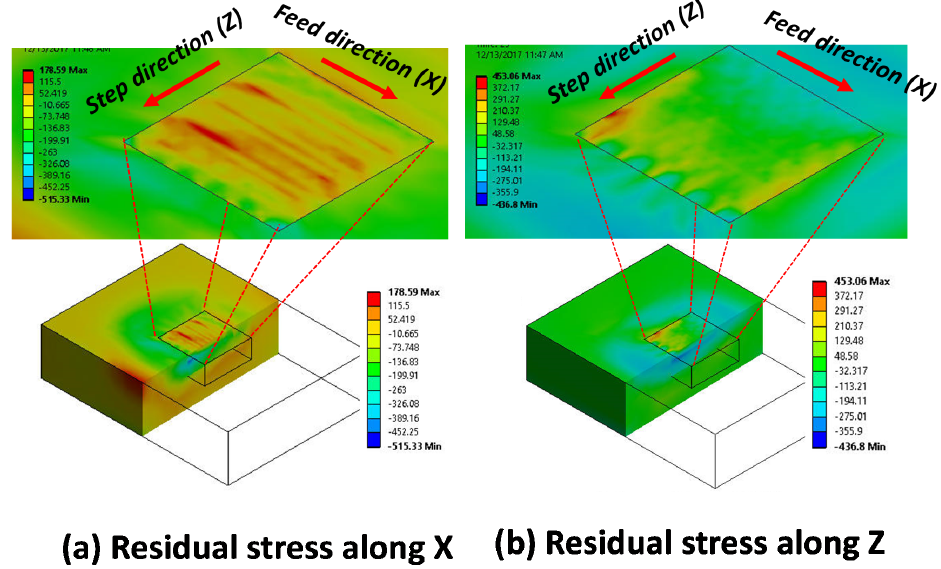
Figure 16. Residual stress distribution on the top surface ( a ) along the X (feed) direction and ( b ) the Z (step-over) direction directions when burnishing at S = 0.05 mm, f = 300 mm/min and F = 1650 N.